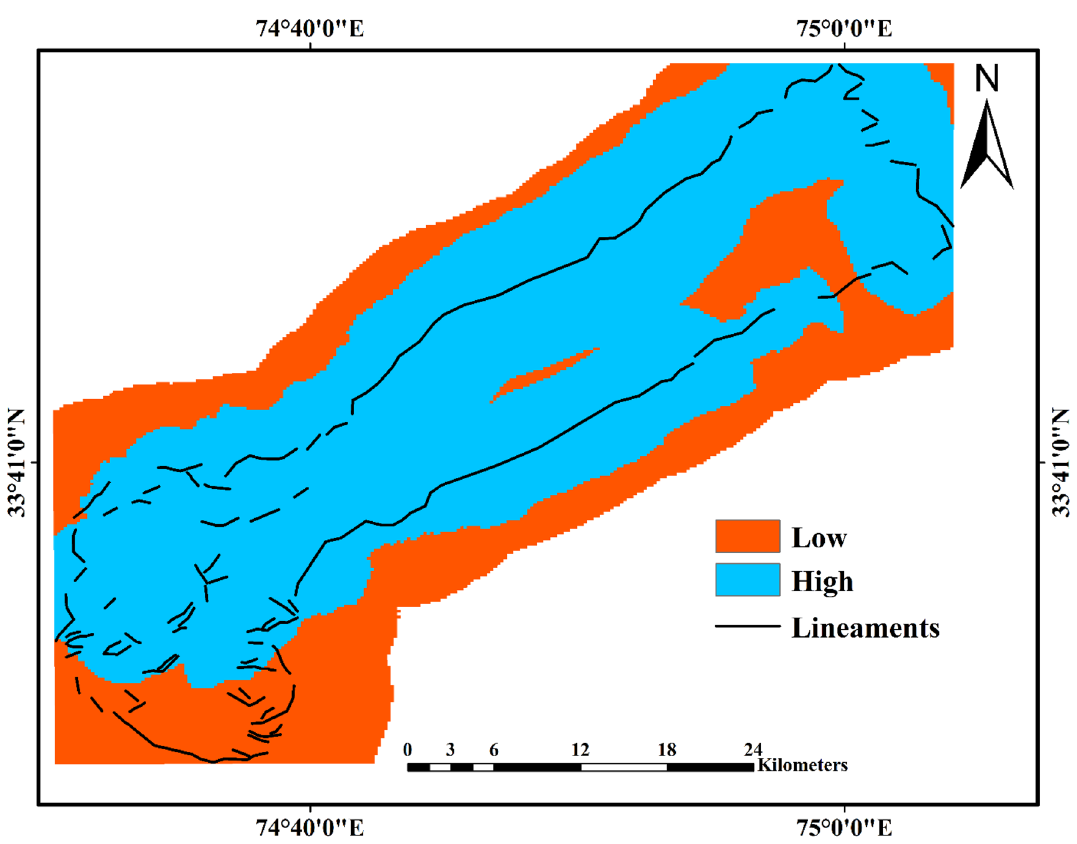
Fig. 7 Lineament density/lineament map of study